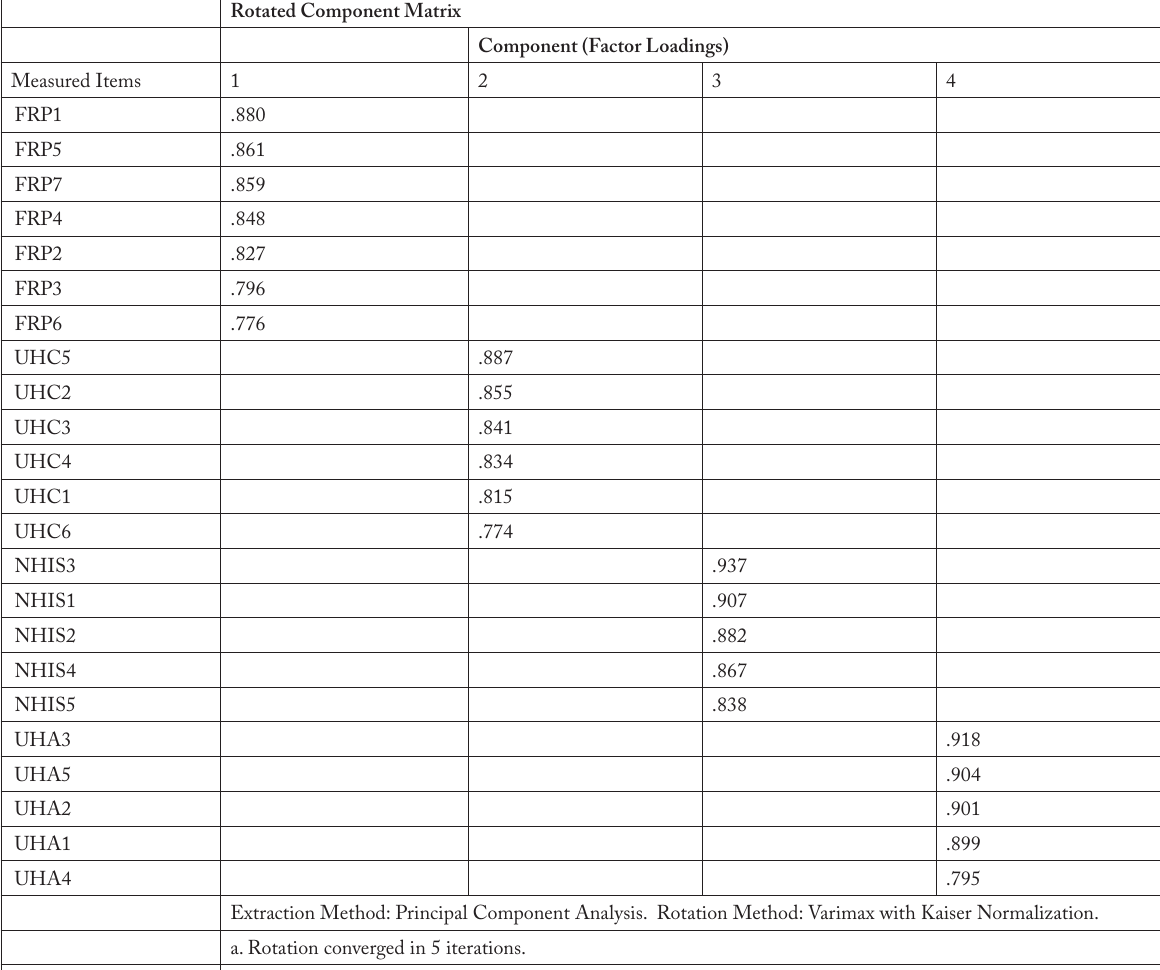
Table 4. Principal component analysis on measured items.